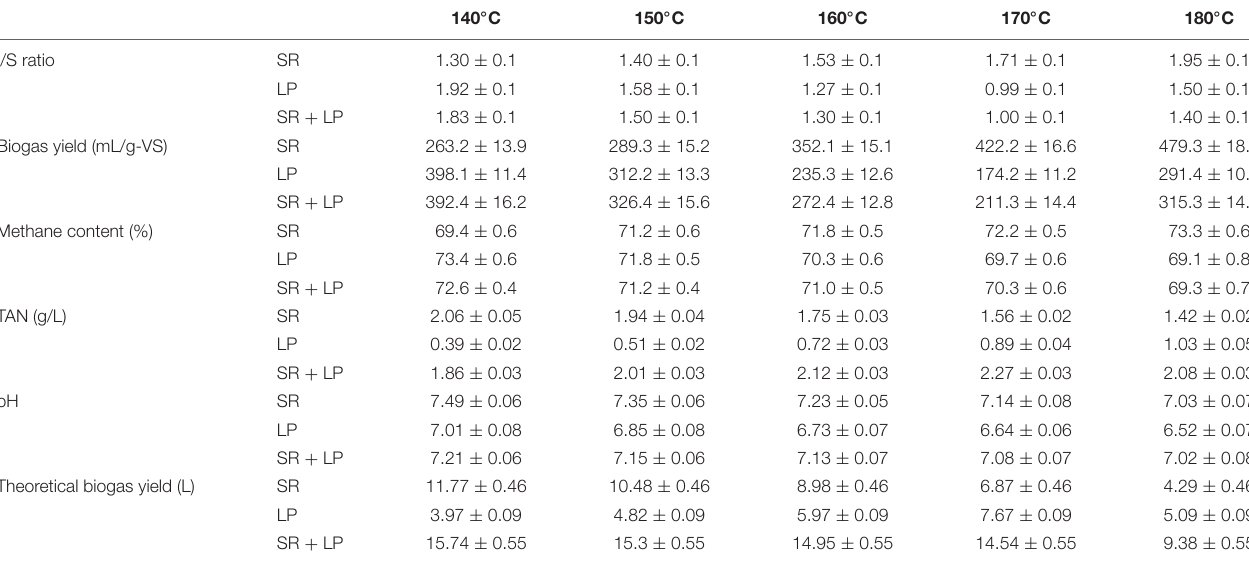
TABLE 2 | The results for biogas production during batch digestion of pork products after